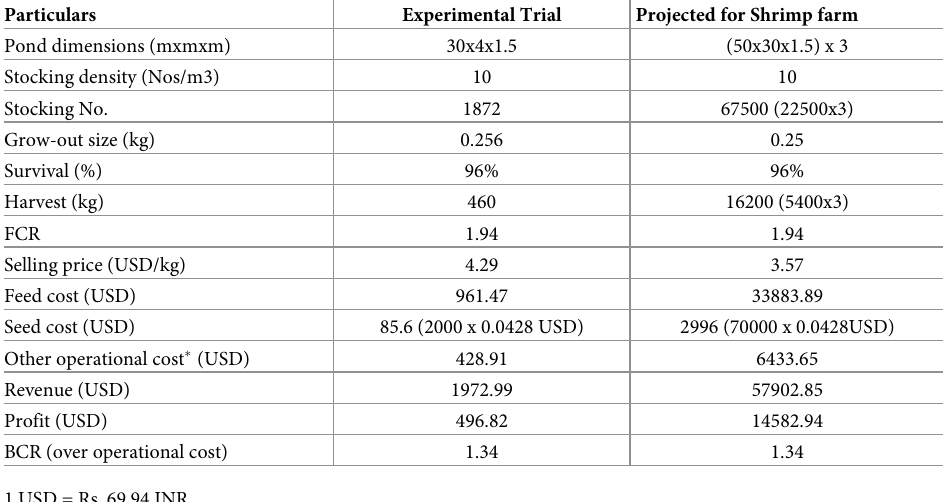
Table 2. Operational cost and economics of the trial and projected farm economics.